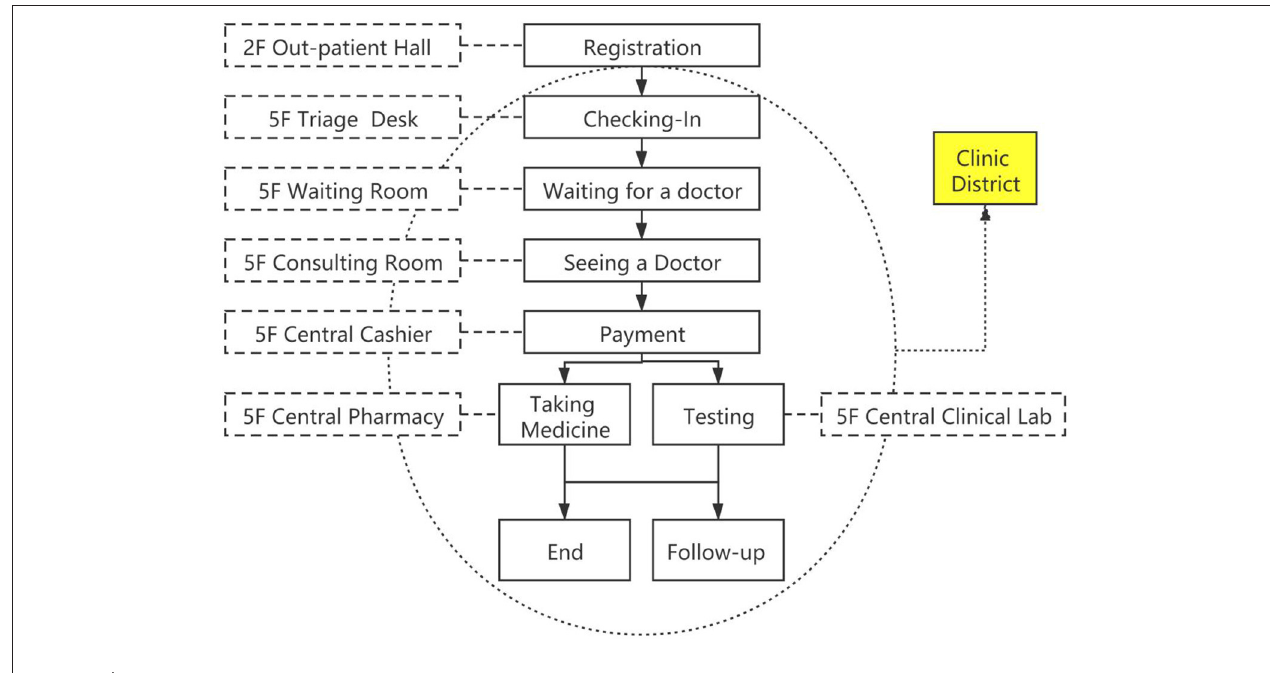
FIGURE 1 | “One-station” outpatient service.